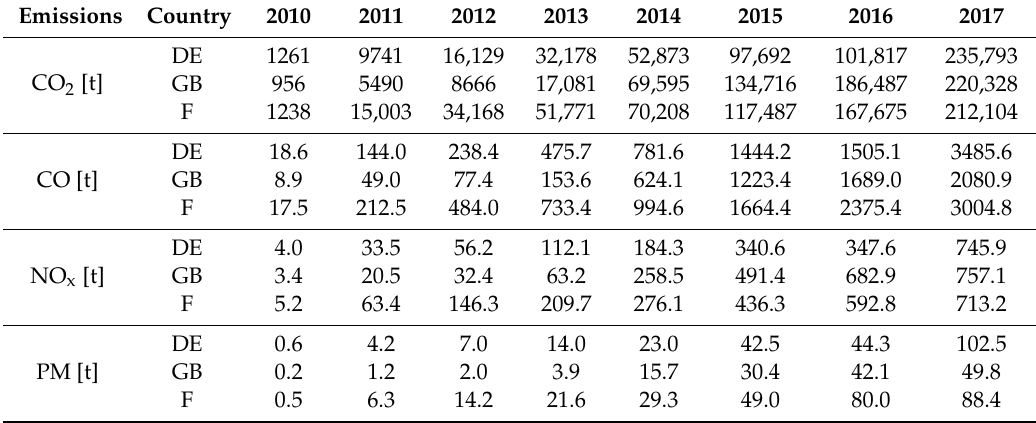
Table 8. Reductions in CO 2 , CO, NO x and PM emissions thanks to the replacement with electric cars in Germany, Great Britain and France in